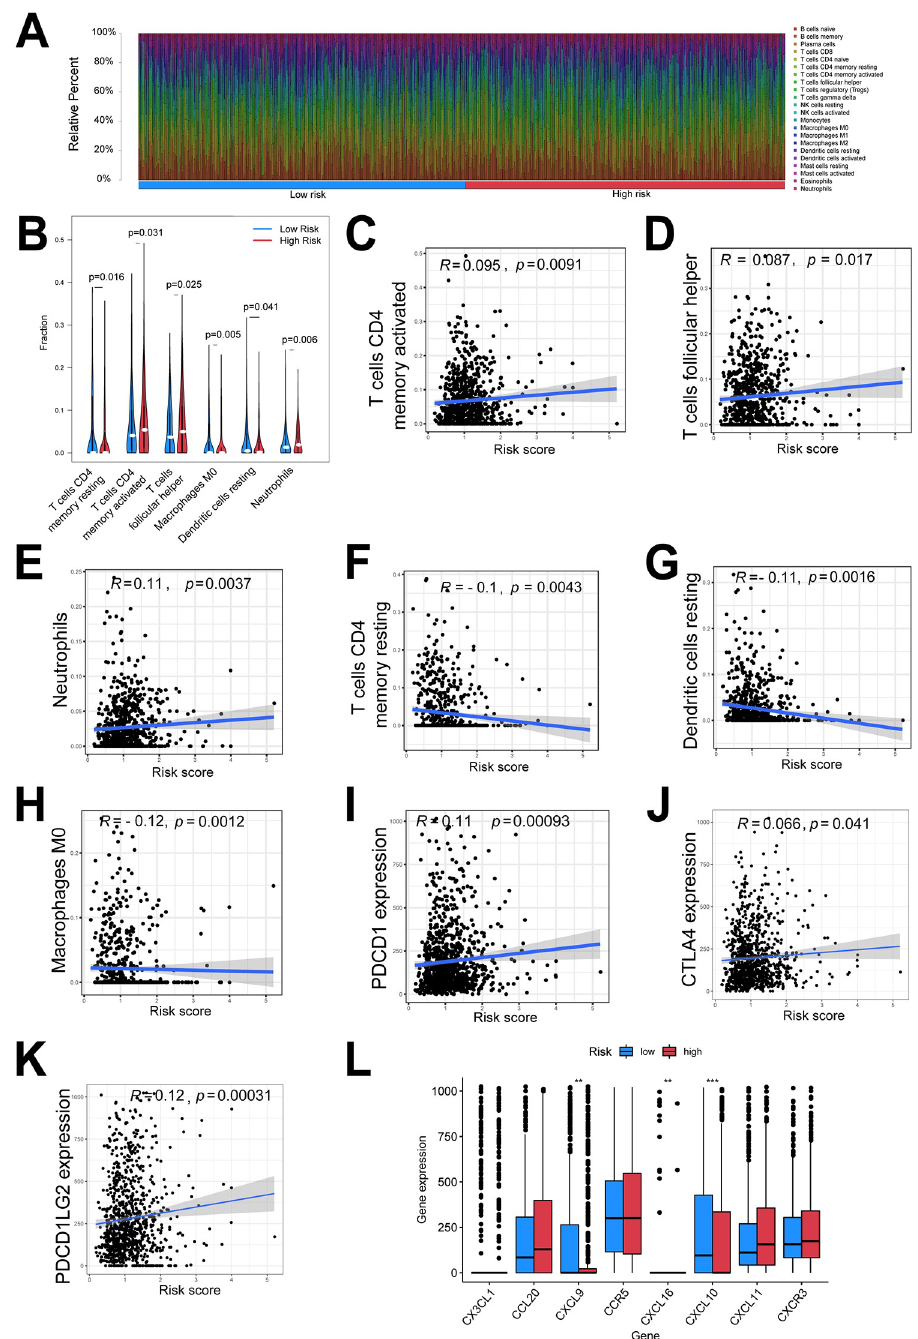
Fig 7. Relationships between the risk score of ceRNA network and tumor immune microenvironment. (A) Landscape of immune cell infiltration between low- and high-risk patients with NSCLC. (B) Fractions of significantly differential immune cell types between low- and high-risk patients with NSCLC. (C–H) Correlations between risk score and infiltration levels of significantly different immune cell types. (I) Comparison of PD-1 expression level between low- and high-risk patients with NSCLC. (J) Correlations between risk score and PD-1 expression levels. (K) Comparison of expression level of chemokines between low- and high-risk patients with NSCLC. NSCLC, non-small cell lung cancer; PD-1, programmed cell death protein